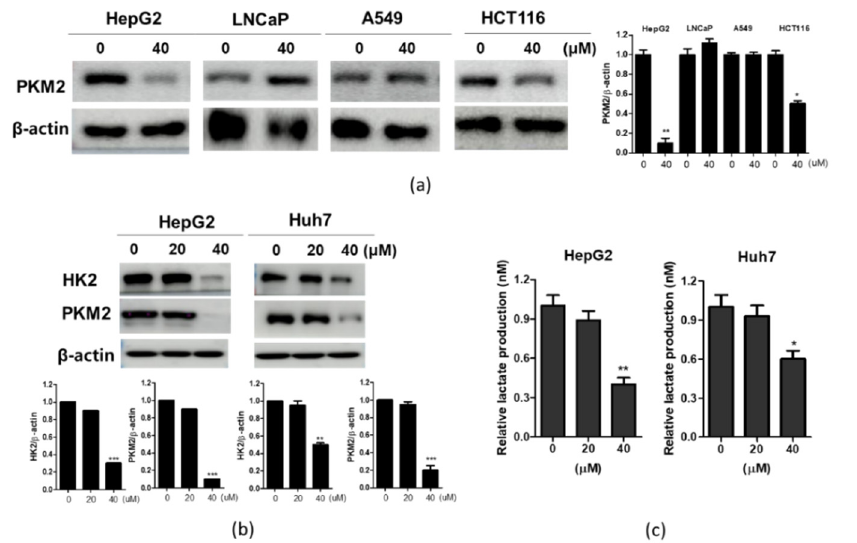
Figure 3. Effect of CB-PIC on expression of HK2 and PKM2 in HepG2 and Huh7 cells. ( a ) Inhibitory effect of CB-PIC on PKM2 in various cancer cell lines (HepG2, LNCaP, A549, HCT116) by Western blotting. ( b ) HepG2 and Huh7 cells were treated with CB-PIC (0, 20 or 40 µ M) for 24 h. Cell lysates were prepared and subjected to Western blotting for HK2 and PKM2. Graphs represent relative level of protein expression/ β -actin. ( c ) Lactate production in conditioned media was measured using Glycolysis Assay kit (ECGL-100). Data represent means ± SD. * p < 0.05, ** p < 0.01, *** p < 0.001 versus untreated